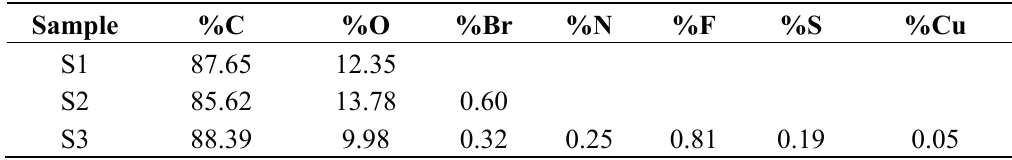
Table 2. XPS analysis for the starting Starbon ® 700 (S1), brominated (S2) and with the CudiolPhBox complex anchored (S3). a